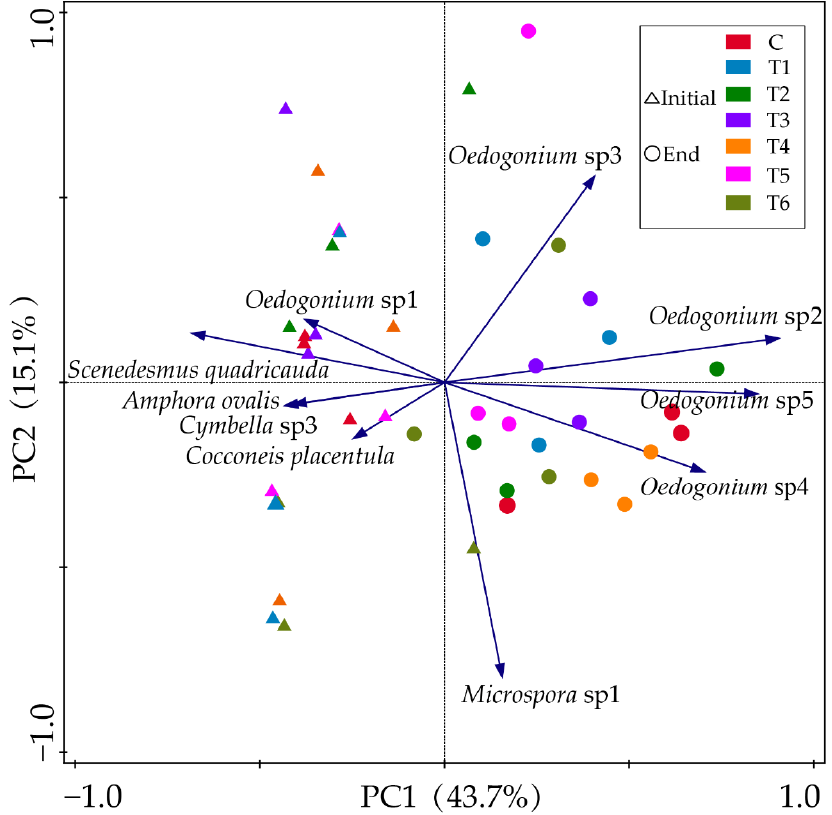
Figure 6. PCA plots of main epiphytic algal species at the initial (triangles) and end (circles) of the experiment. Colors represent different groups. Abbreviations for groups are the same as in Figure